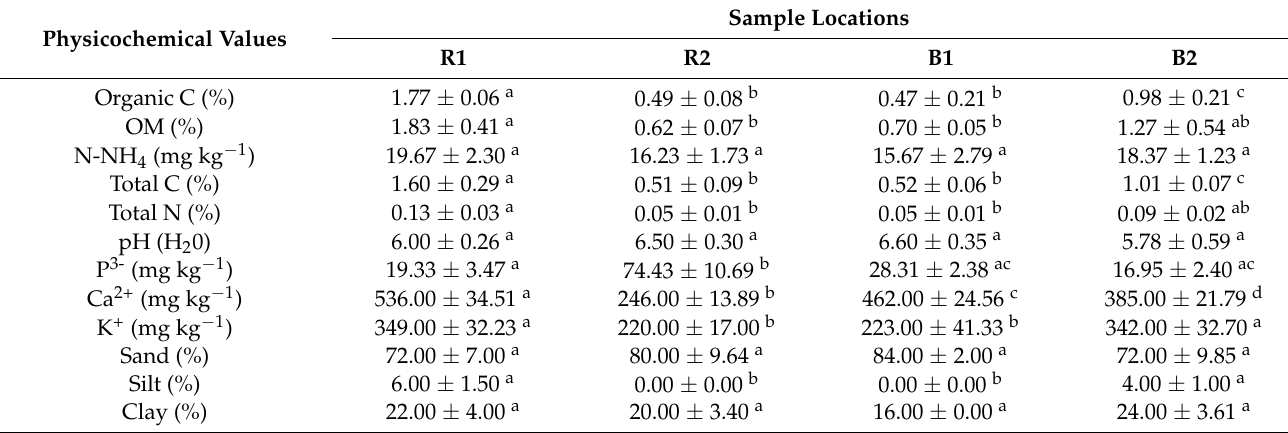
Table 1. Physicochemical properties of the soil rhizosphere (R1 and R2) and bulk soil samples (B1 and B2) of two sunflower fields in South Africa, Palmietfontein (R1, B1), and Bloemhof (R2, B2).